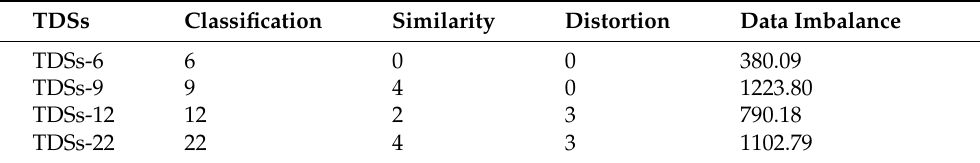
Table 3. The reconstructive basic of four task datasets depends on Classification, Similarity, and Dis- tortion. Additionally, the data imbalance is presented here.